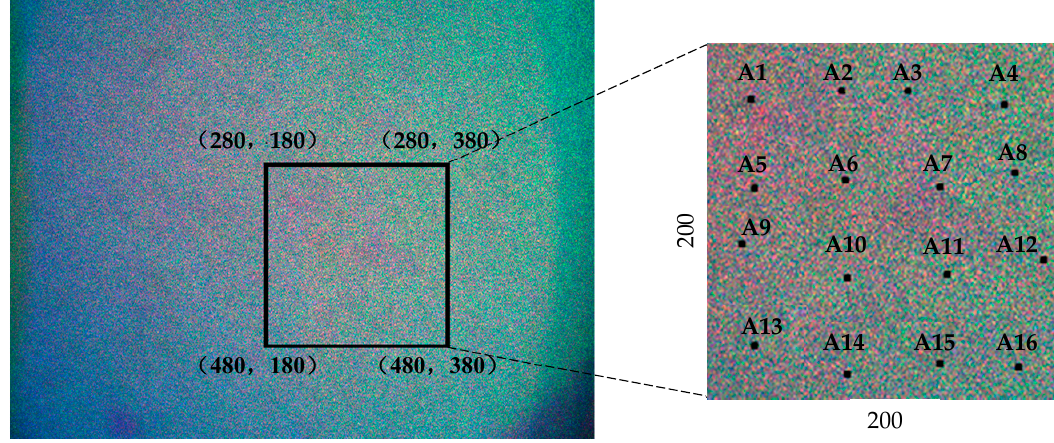
Figure 14. The ROI selected and the points processed.